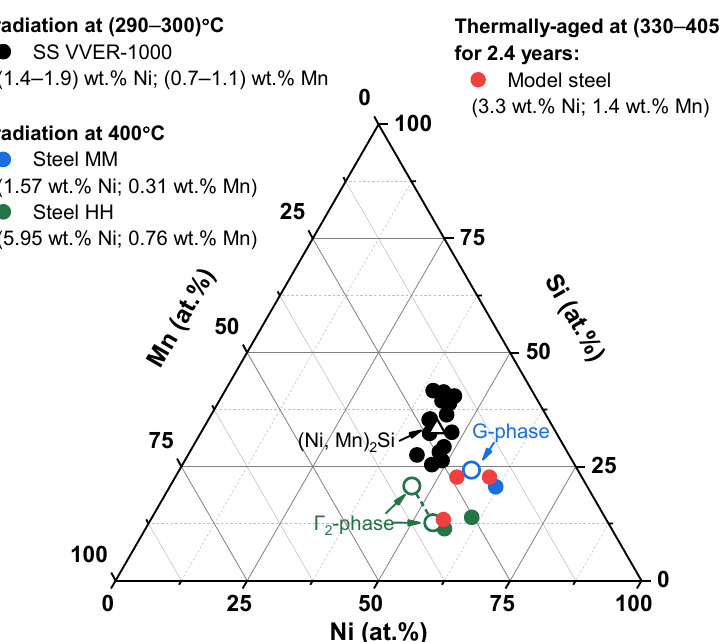
Figure 4. Ni-Si-Mn triple diagram with marked areas of precipitates composition in various steels (precipitates compositions in SS VVER-1000 [6] and in thermally-aged model steel [13] are also marked).